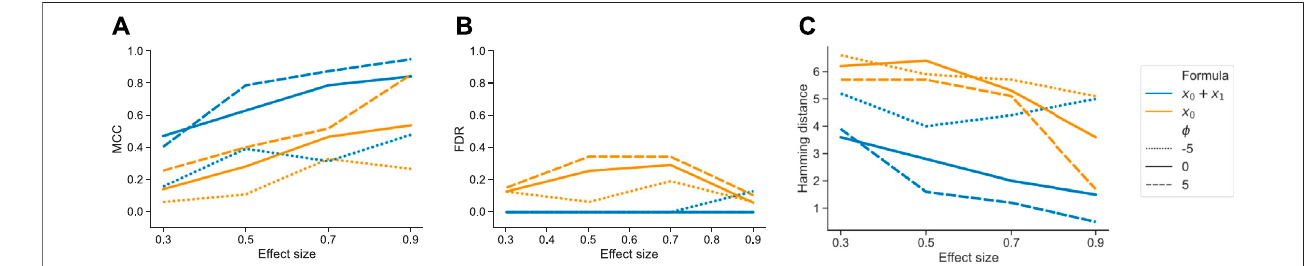
FIGURE4| PerformancecomparisonfortascCODAonsimulateddatawithtwocovariates.Thesetupsincludingbothoronlyonecovariateinthemodelareshown as x 0 + x 1 and x 0 , respectively. Simulations were evaluated for different effect sizes and aggregation levels ϕ . Performance measured by (A) Matthews correlation coef fi cient (MCC). (B) False discovery rate (FDR) (C) Hamming distance between ground truth and determined